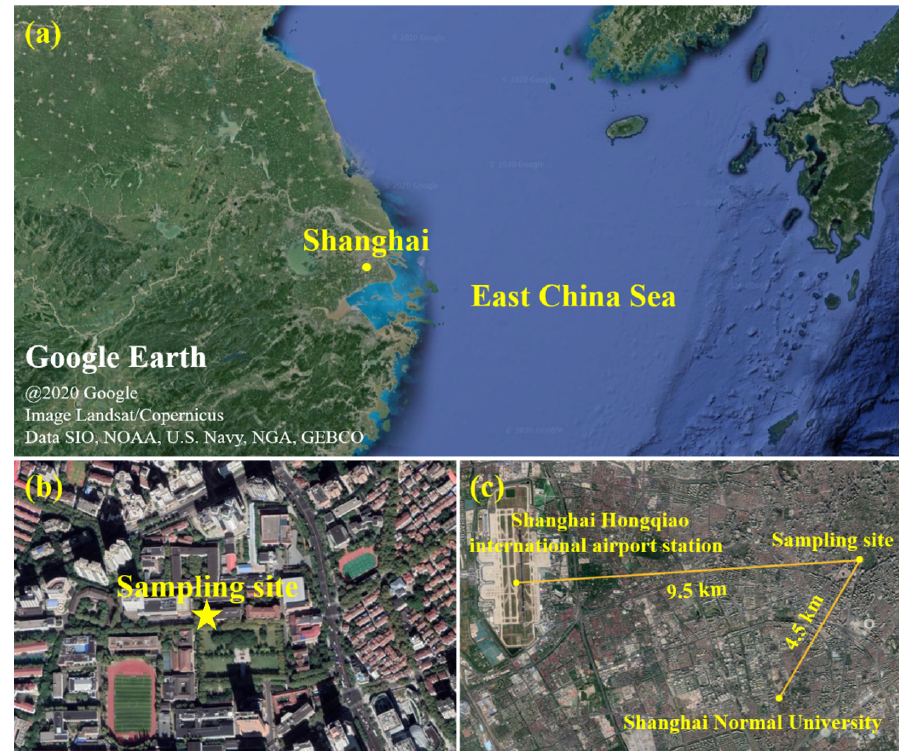
Figure 1. (a) Map of Shanghai. (b) Map of the sampling site on the Xuhui Campus of Shanghai Jiao Tong University in downtown Shanghai at 31.201 ◦ N, 121.429 ◦ E. (c) Map of the PM 2 . 5 sampling site, the meteorological station at Shanghai Hongqiao international airport, the air quality monitoring station at Shanghai Normal University, and the distances between